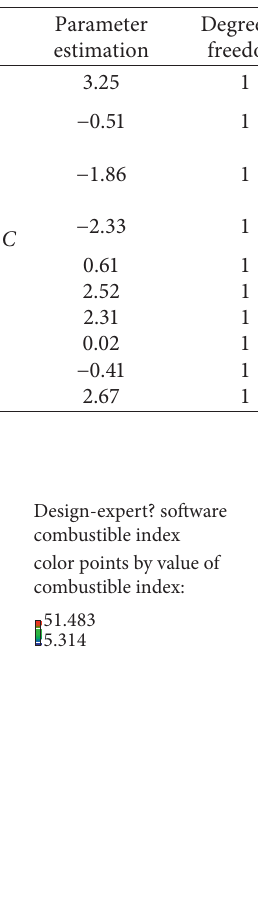
Table 12: The confidence of the two equations for combustibility index.